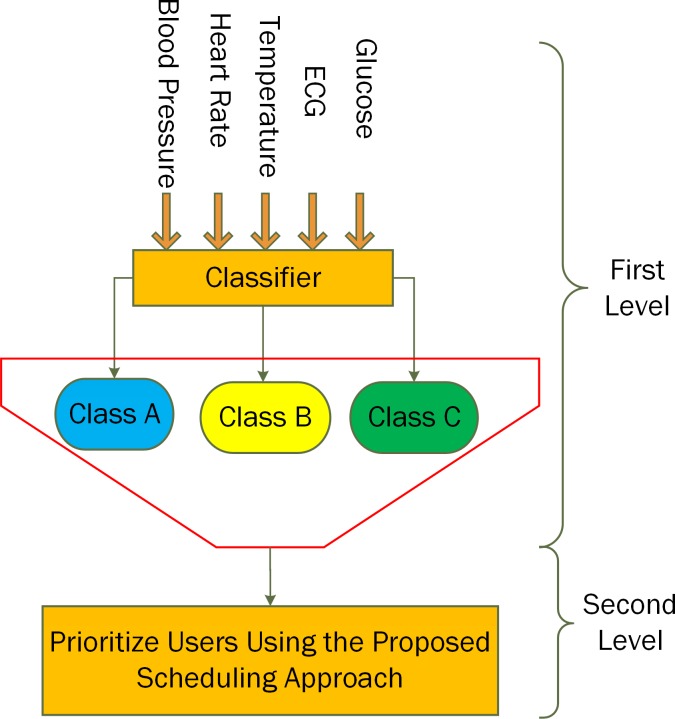
Main system diagram.